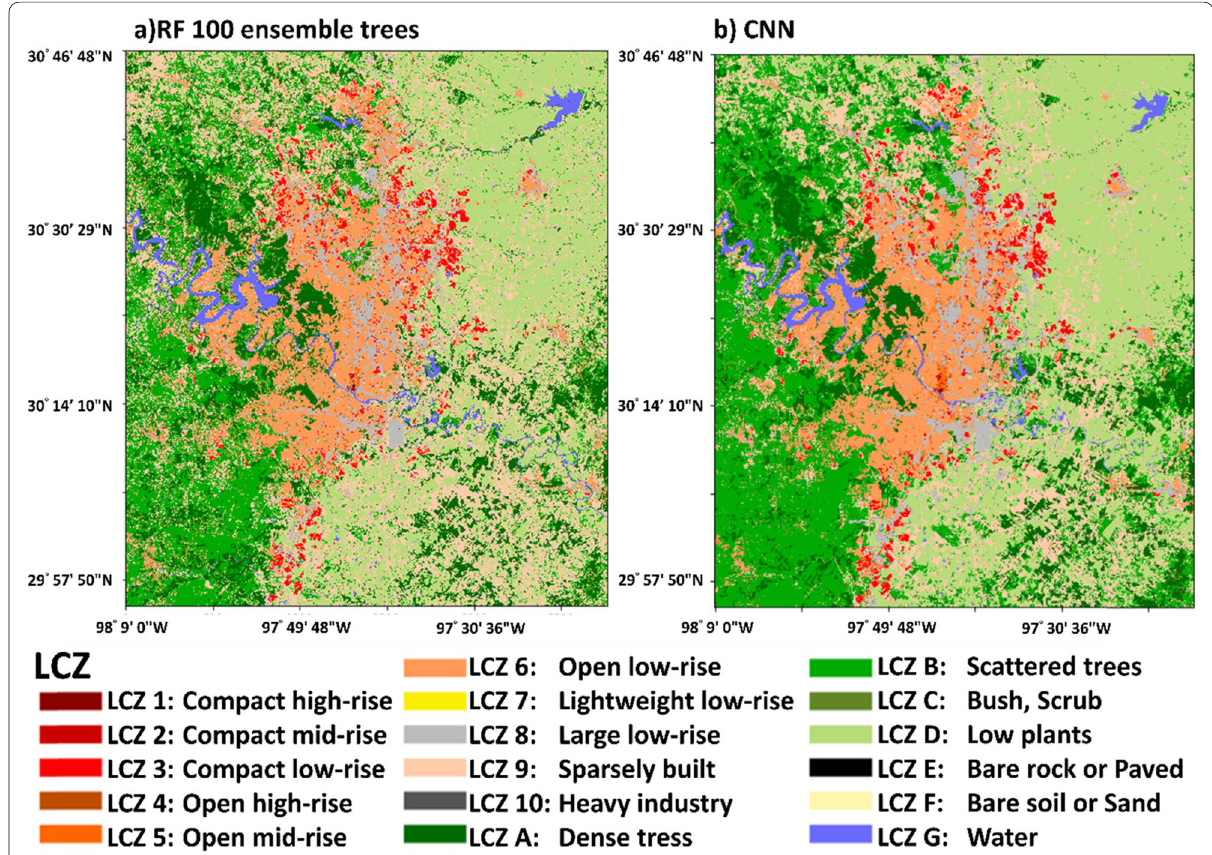
Fig. 12 The LCZ products derived from a RF100 and b CNN classifier using LS8